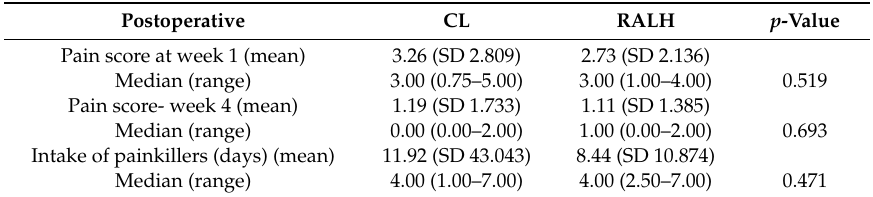
Table 3. Postoperative pain scores and intake of painkillers.